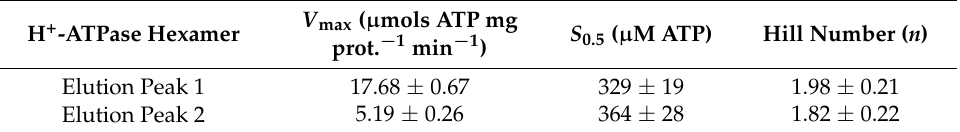
Table 1. Kinetics parameters of the isolated H + -ATPase hexamers at 25 ◦